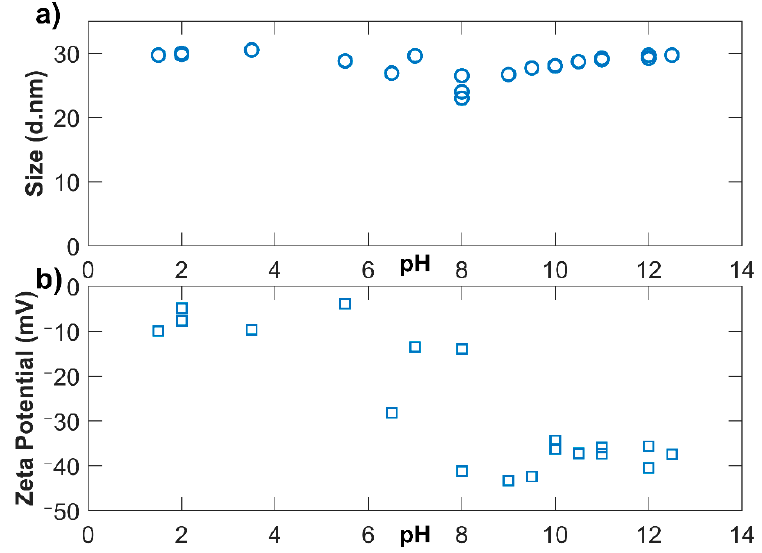
Figure 6. pH adjustment of NS-20b with 0.1 M HCl and 0.1 M KOH; ( a ) displays z-average while ( b ) reports zeta potential.